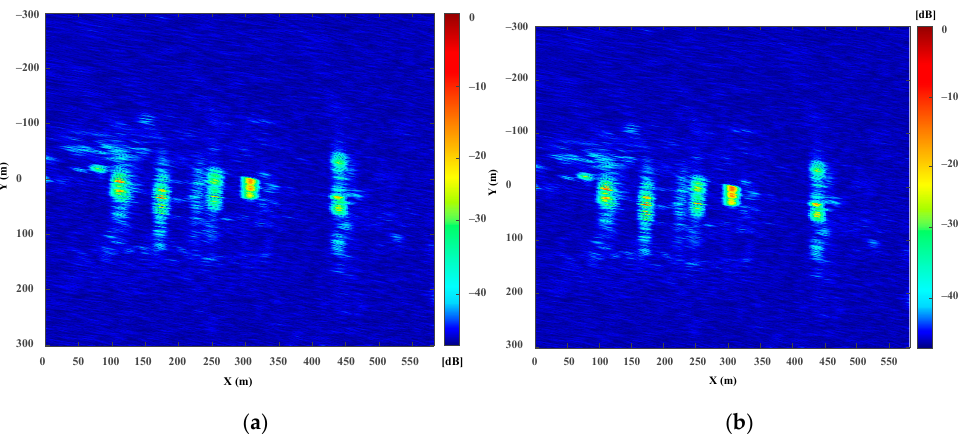
Figure 9. Comparison between imaging results, ( a ) is the imaging results of CPU, ( b ) is the imaging results of GPU.